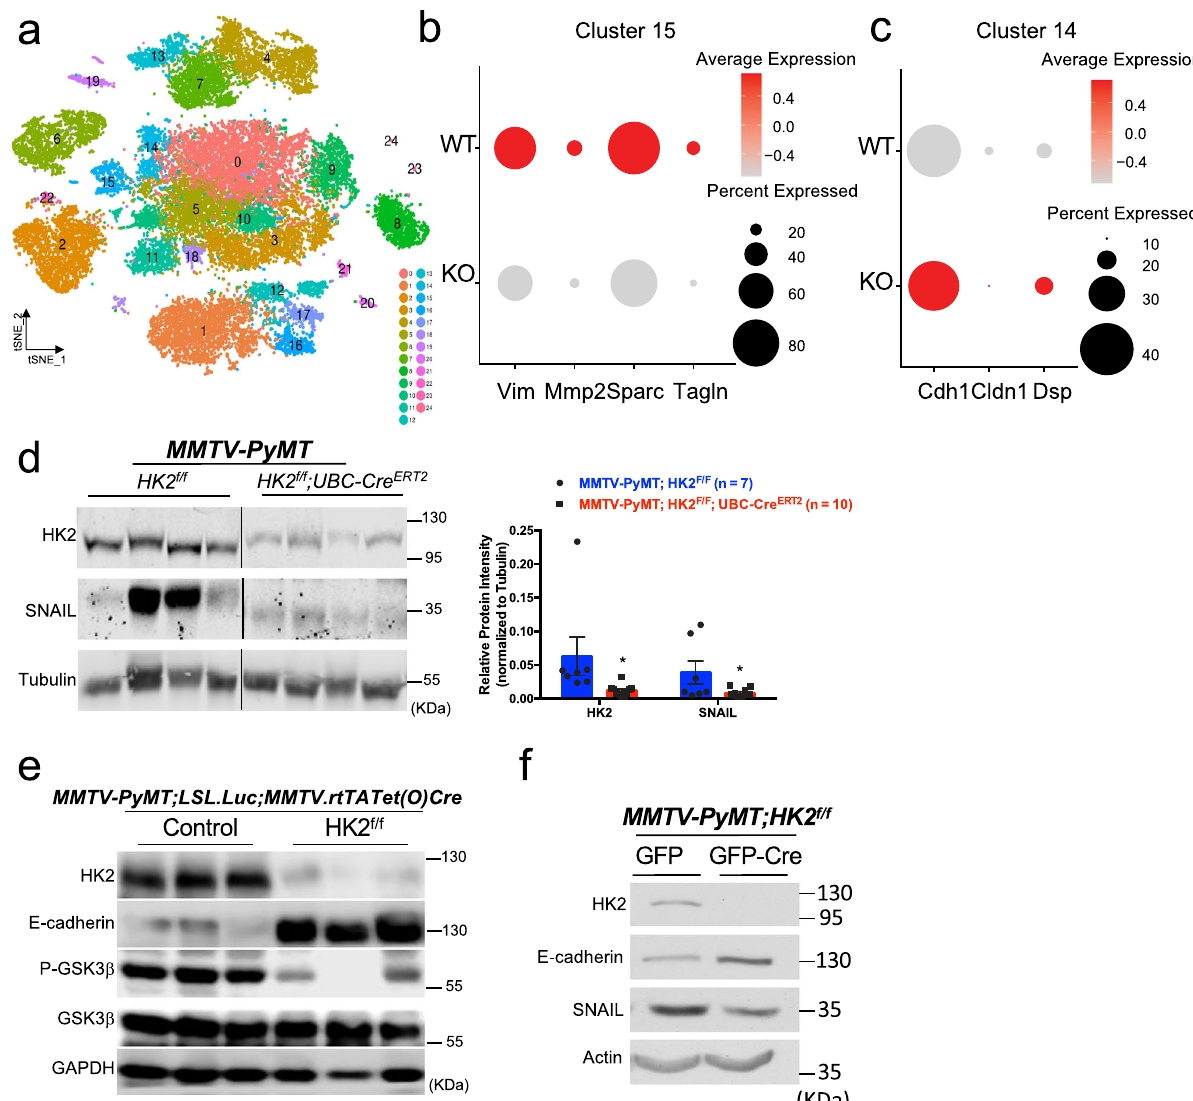
Fig. 7 The effect of HK2 deletion on speci fi c SNAIL target gene expression in epithelial and mesenchymal cell clusters and SNAIL protein levels in the primary tumors. a Single-cell RNA sequencing and clustering of primary tumor cells derived from tumors at end-point of MMTV-PyMT;HK2 f/f ( n = 7) and MMTV-PyMT;HK2 f/f ;UBC-Cre ERT2 ( n = 8) mice after TAM exposure. t-Distributed Stochastic Neighbor Embedding (tSNE) is shown. The color-coded clusters are grouped together by similar gene expression. Twenty- fi ve clusters including nine primary tumor PyMT-expressing clusters were identi fi ed. b Dot plot showing the expression of SNAIL targets important for EMT and metastasis (Vim, Mmp2, Sparc, Tagln) in Cluster 15 from WT and KO (MMTV- PyMT;HK2 f/f and MMTV-PyMT;HK2 f/f ;UBC-Cre ERT2 ) tumors after TAM exposure at tumor onset. High RNA expression is indicated by a dark red color. c Dot plot showing the expression epithelial markers such as E-cadherin (Cdh1), Claudin-1 (Cldn1), and Desmoplakin (DSP) in Cluster 14 from WT and KO ( MMTV-PyMT;HK2 f/f and MMTV-PyMT;HK2 f/f ;UBC-Cre ERT2 tumors after TAM exposure at tumor onset). A high RNA expression is indicated by a dark red color. d Left: immunoblot image of HK2 and SNAIL protein levels in tissue samples collected from primary mammary gland tumors at end-point after exposure to TAM at tumor onset, in MMTV-PyMT;HK2 f/f and MMTV-PyMT;HK2 f/f ;UBC-Cre ERT2 mice. Right: quanti fi cation of HK2 and SNAIL protein levels, MMTV-PyMT;HK2 f/f ( n = 7 tumors from four different mice), MMTV-PyMT;HK2 f/f ;UBC-Cre ERT2 ( n = 10 tumors from six different mice). Results are the mean ± SEM. * p = 0.048 versus MMTV-PyMT;HK2 f/f ; unpaired two-tailed t -test. e Immunoblot image of HK2, pGSK3b, GSK3 β , E-cadherin, and SNAIL protein levels in primary mammary tumors at end-point derived from MMTV-PyMT;LSL.Luc;MMTV.rtTATet(O)Cre control mice ( n = 3) or MMTV- PyMT;HK2 f/f ;LSL.Luc;MMTV.rtTATet(O)Cre mice ( n = 3) subjected to DOX diet after tumor onset. f Representative immunoblot image of HK2, E-cadherin, and SNAIL protein levels in protein extracts from cells isolated from tumors in MMTV-PyMT;HK2 f/f mice after infection with adenovirus expressing either GFP or GFP-Cre. Similar results obtained in three independent experiments. Uncropped blots are provided as a Supplementary Fig. 16. Source data are provided as a Source Data fi